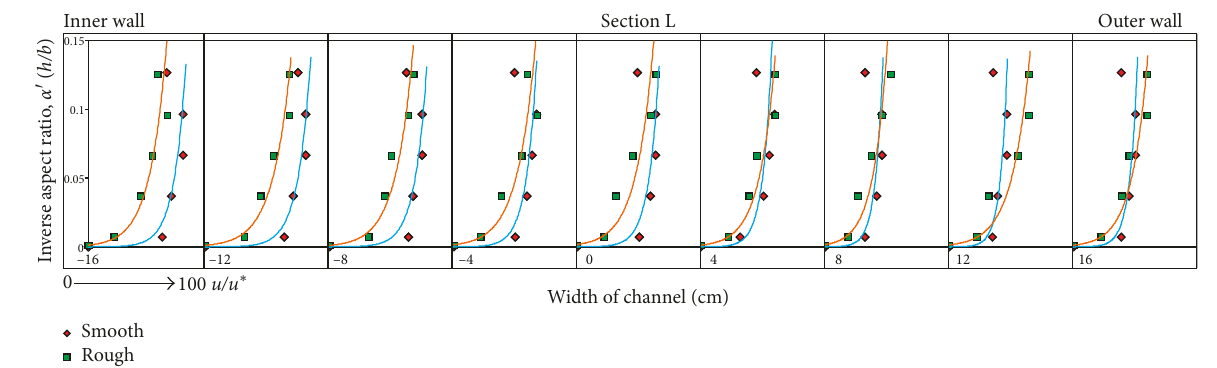
Figure 15: Comparison of velocity variation in section